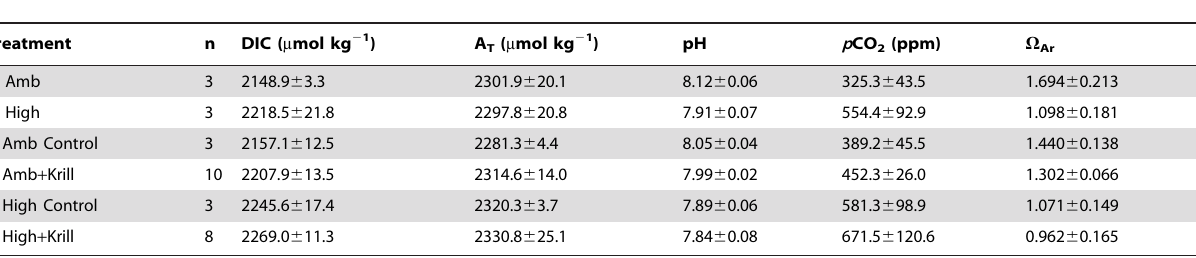
Table 1. Carbonate